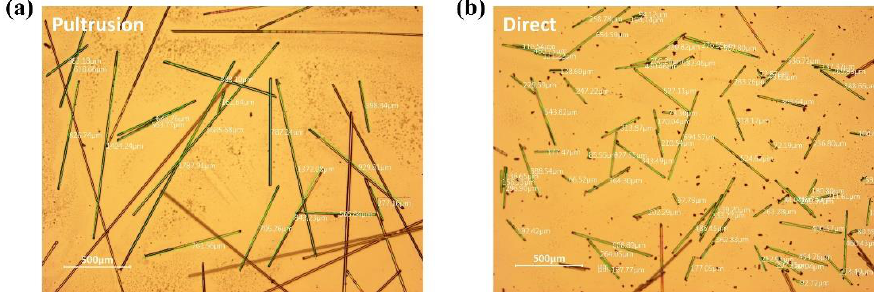
Figure 10. OM images of the GF fiber lengths from the pultrusion and direct extrusion processes: ( a ) pultrusion; ( b ) direct.